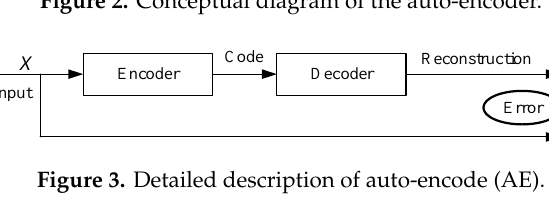
Figure 4. Stepwise diagnosis process.